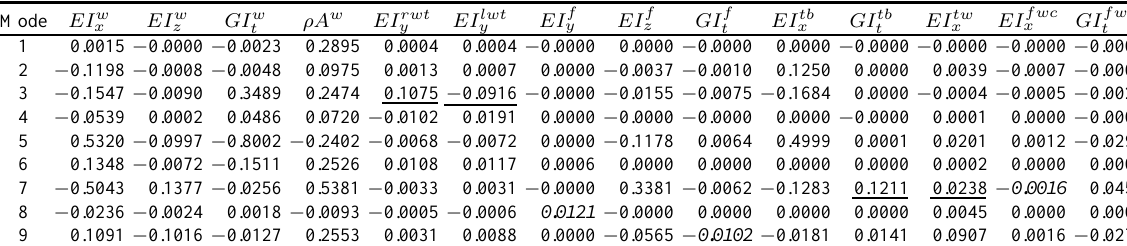
Table 5 Sensitivity matrix of MAC to model